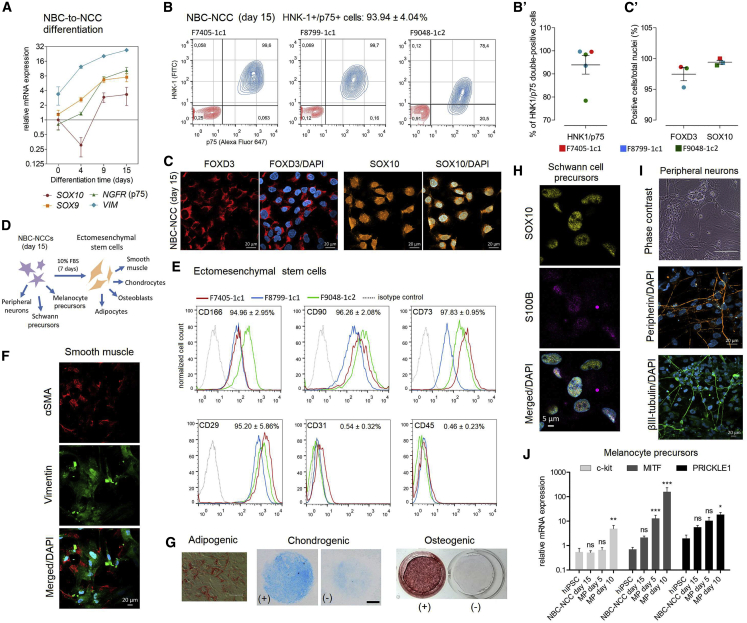
NBCs Can Be Efficiently Converted into Multipotent NCCs(A) qRT-PCR for NC specifiers SOX9/10, NC marker NGFR (p75), and mesenchymal marker VIM (vimentin) during NBC-to-NCC induction. Data are plotted as mean ± SEM (n = 3 biological replicates).(B and B′) Representative flow cytometry analysis for NC markers HNK-1 and p75 depicting double-positive cells (blue) versus isotype (negative) control staining (red). Individual values are plotted in (Bʹ) (n = 3 biological replicates).(C and C′) Representative immunostaining for FOXD3 and SOX10; quantification of positive cells/total nuclei is plotted in (Cʹ). Bars represent means ± SEM (n = 3 biological replicates).(D) Diagram depicting terminal differentiations of NBC-NCCs.(E) Flow cytometry profiles of ectomesenchymal stem cells differentiated from NBC-NCCs for mesenchymal markers CD73, CD90, CD166, and CD29, endothelial marker CD31, and hematopoietic marker CD45. Quantification was done in relation to isotype (negative) controls (n = 3 biological replicates).(F–I) Representative differentiations of NBC-NCCs (n = 3 biological replicates): (F) αSMA/Vimentin staining (smooth muscle cells). Scale bar, 20 μm. (G) Oil red O, alizarin red, and Alcian blue staining (adipogenic, osteogenic, and chondrogenic differentiation, respectively). Scale bars, 400 μm (oil red O) and 1 mm (Alcian blue). +, differentiated cells; −, negative control. (H) SOX10/S100B staining (glial/Schwann cell precursors). Scale bar, 5 μm. (I) Morphology of peripheral neurons and βIII-tubulin and peripherin staining. Scale bar, 20 μm.(J) Melanocyte differentiation. qRT-PCR for melanocyte precursor (MP) markers MITF, c-kit, and PRICKLE1.Means ± SEM were plotted against undifferentiated hiPSCs (n = 3 biological replicates). ∗∗∗p < 0.001, ∗∗p < 0.01, ∗p < 0.05; one-way ANOVA with Dunnett's correction.